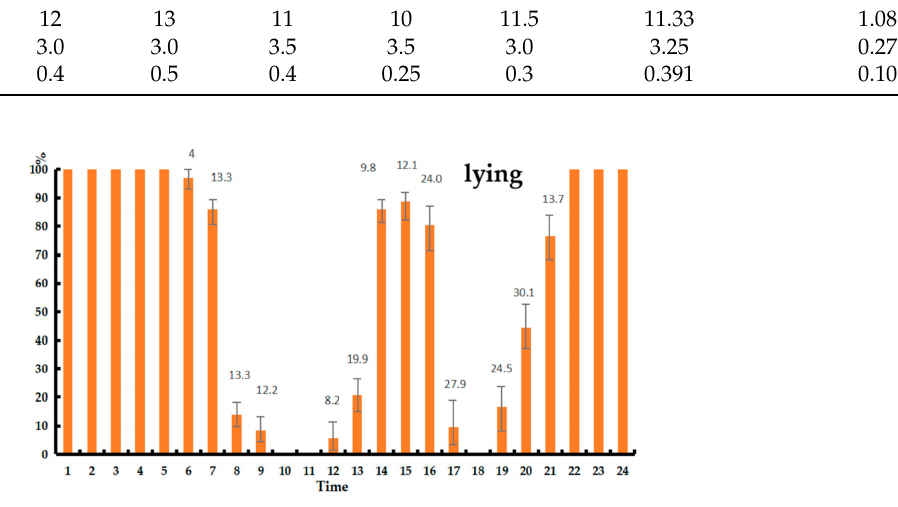
Figure 15. The distribution of time spent on lying, standing, feeding and drinking within 24